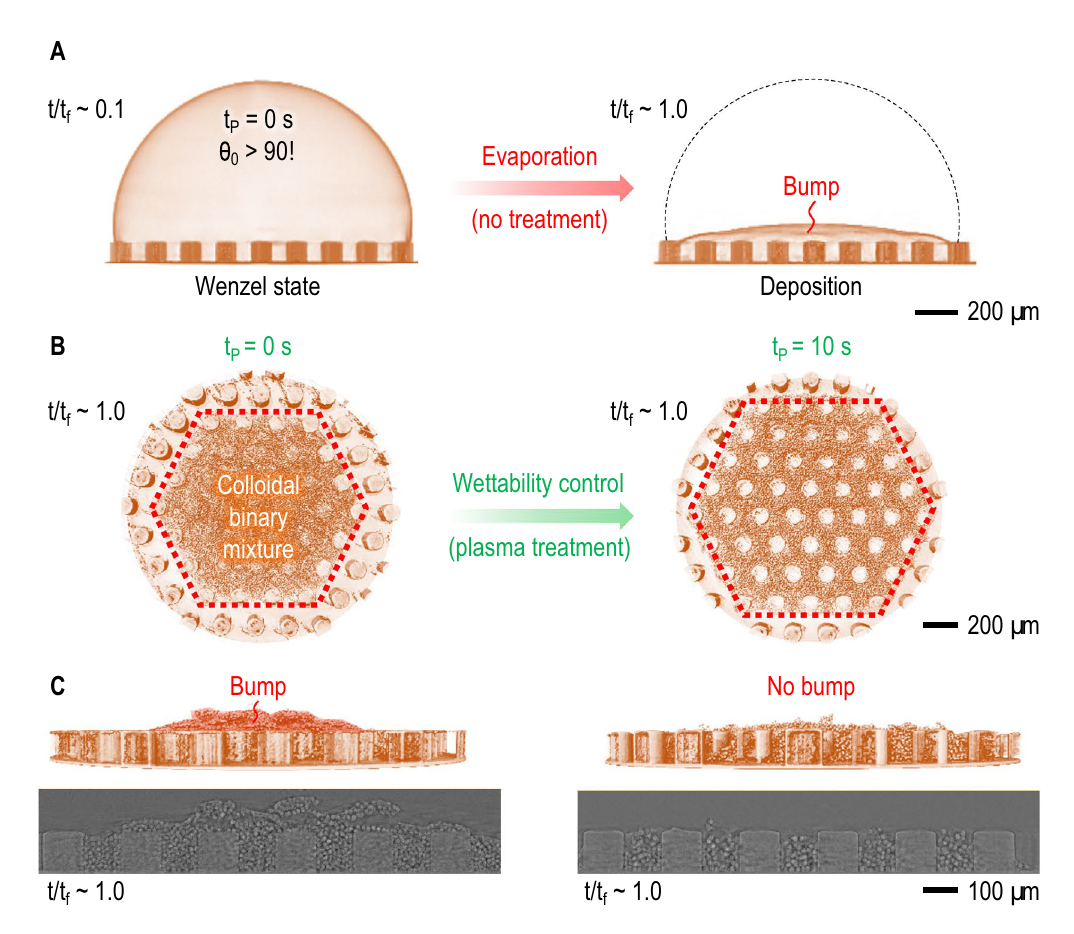
Figure 1. X-ray microtomography of evaporation-mediated deposition of binary colloids. ( A ) Starting colloidal droplets on PDMS micropillar patterns (left: at initial time t / t f ∼ 0.1 ( t f = evaporation complete time) ◦ with no treatment (initial contact angle θ 0 > 90 , showing Wenzel wetting state) results in bump formation after evaporation (right: at final time t / t f ∼ 1.0). ( B ) By adopting plasma treatment for wettability control of micropillar patterns (plasma treatment time: t p = 10 s), symmetrically hexagonal-shaped uniform deposits are achieved after evaporation ( t / t f ∼ 1.0). ( C ) Bump formation after evaporation ( t / t f ∼ 1.0) is successfully prevented by adopting wettability control of micropillar patterns, as proven by the side-view (upper) and the cross-sectional (lower) images. All images generated with Amira software (version